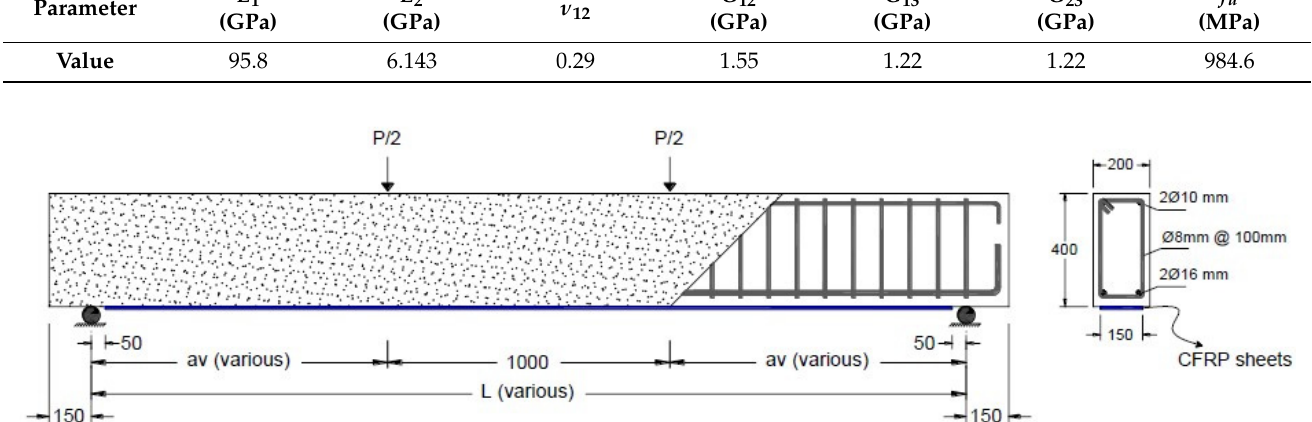
Table 5. Properties of the CFRP reinforcement used in FE simulation, tested by Al-Saawani et al. [6]. Parameter Value